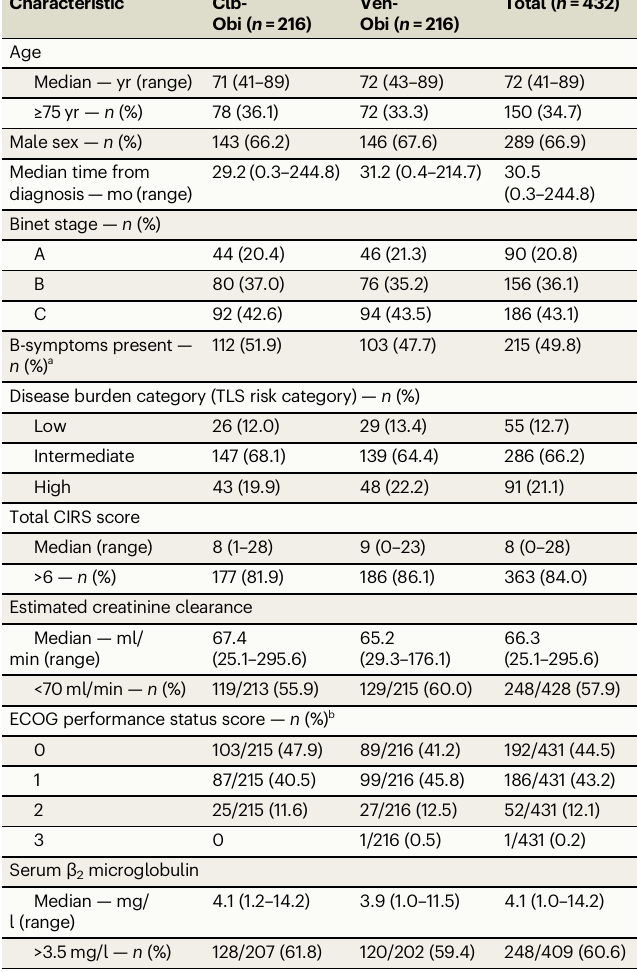
Table 1 | Patient demographic and disease characteristics at baseline